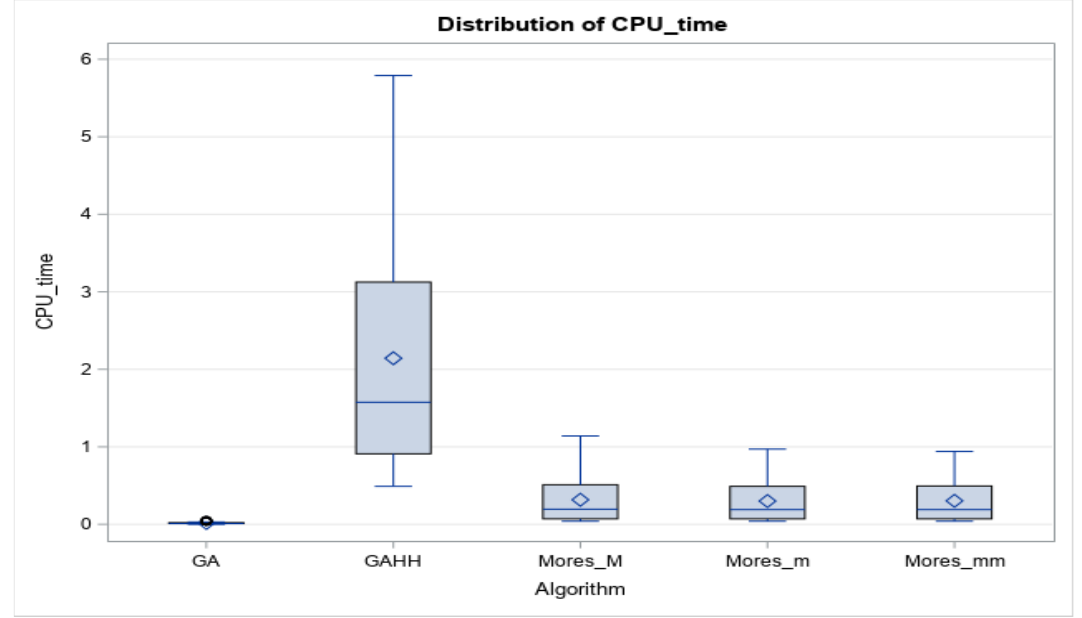
Figure 6. Boxplots of CPU times of the heuristics and algorithms (large n ).